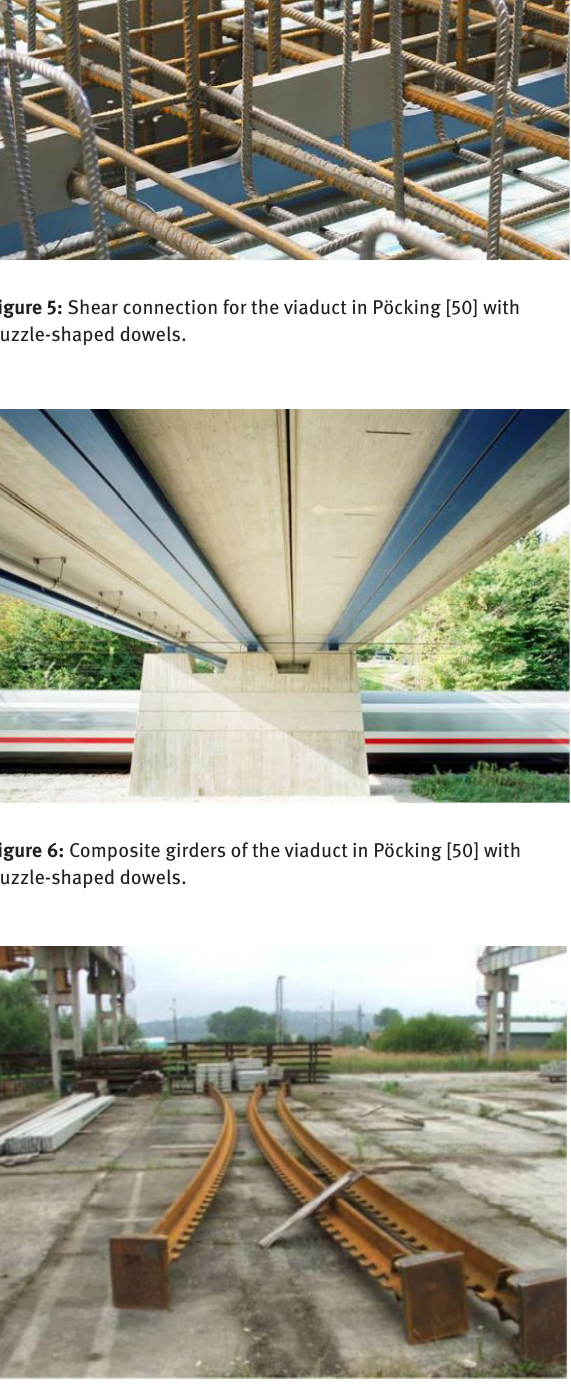
Figure 7: Steel part (“external reinforcement”) of the girders for the pedestrian bridge in Przemyśl, Poland (picture from the proposal of the PreCo-Beam project [7]).